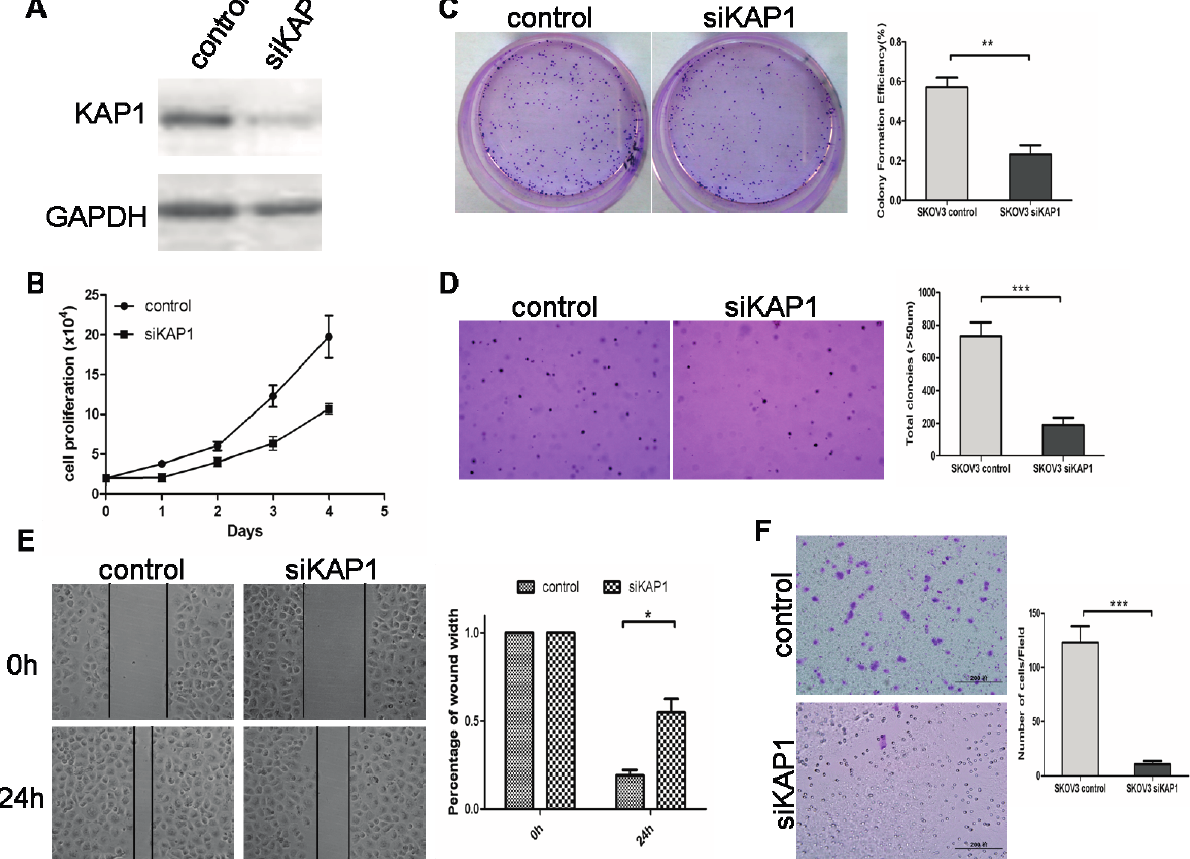
Figure 5. Downregulated expression of KAP1 inhibits cell growth and migration in SKOV3 cells. ( A ) western blot indicates KAP1 interference efficiency; ( B ) MTT assay at 0, 24, 48, 72 and 96 h after transfection; ( C ) representative images of two-dimensional culture of cells; ( D ) representative images of soft agar colony formation assay of cells (100×); ( E ) photographs representing the cells migrated into the wounded area, and histogram showing the relative migration distance of cells in the wound-healing assay (200×) and ( F ) transwell migration assay (100×). ( * p < 0.05; ** p < 0.01; *** p <